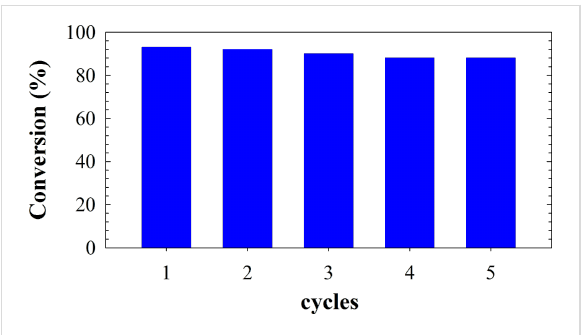
Figure 8: Conversion against number of catalytic cycles for the prepar- ation 1-phenyl-1 H -1,2,3,4-tetrazole with Cu NPs/bentonite for five successive cycles. Conditions: aniline (2 mmol), NaN 3 (2 mmol), triethyl orthoformate (2.4 mmol), catalyst (0.05 g) at 120 °C, 3